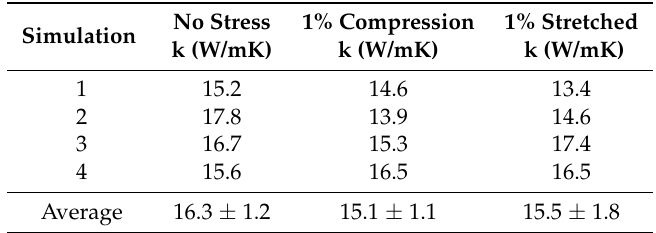
Table A5. Thermal conductivity of a 3 × 3 × 132 Platinum structure under different mechanically induced